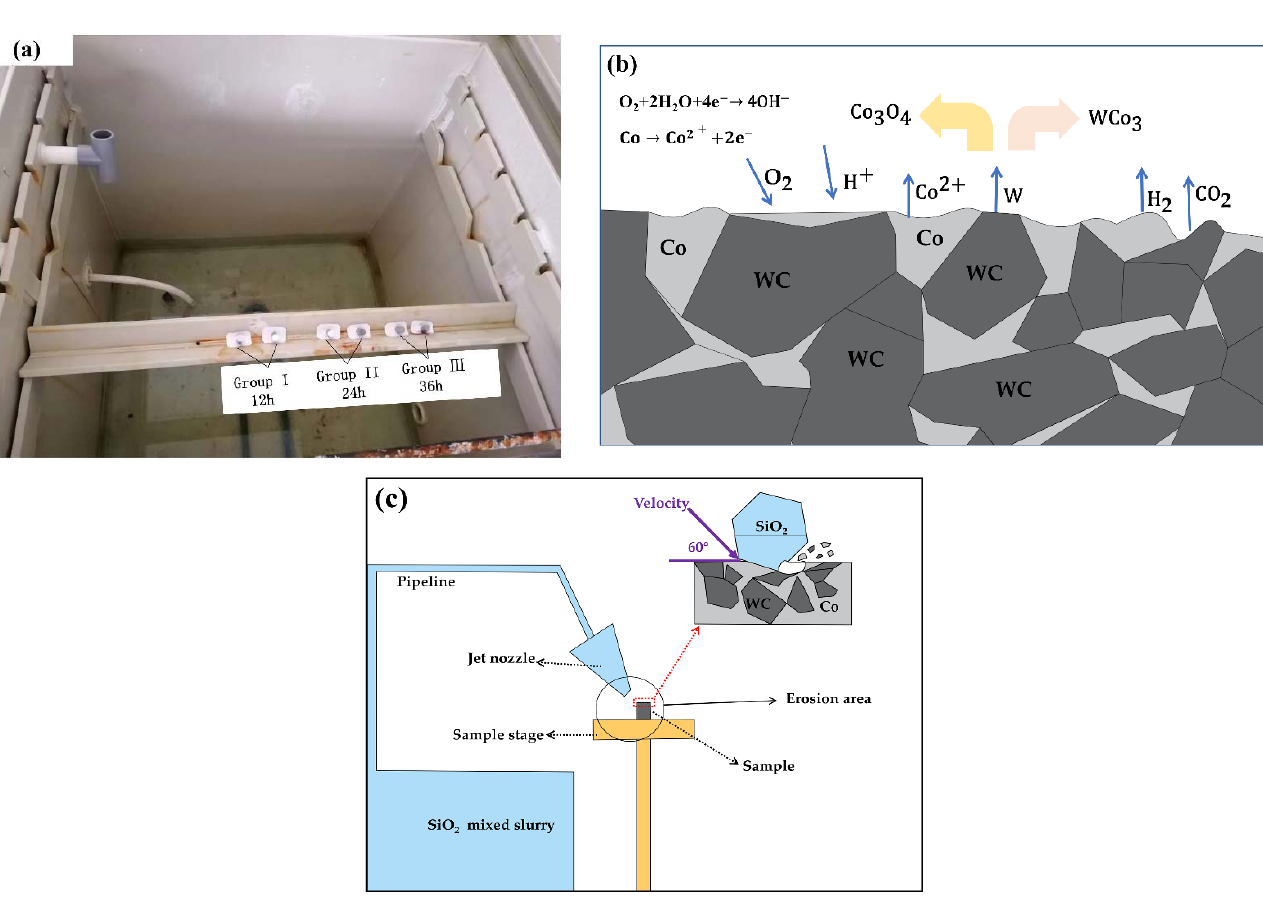
Figure 3. ( a ) Salt spray test sample placement diagram, ( b ) basic principle of salt spray corrosion process of cemented carbide, ( c ) schematic diagram of erosion. Table 3. Salt spray test parameters.